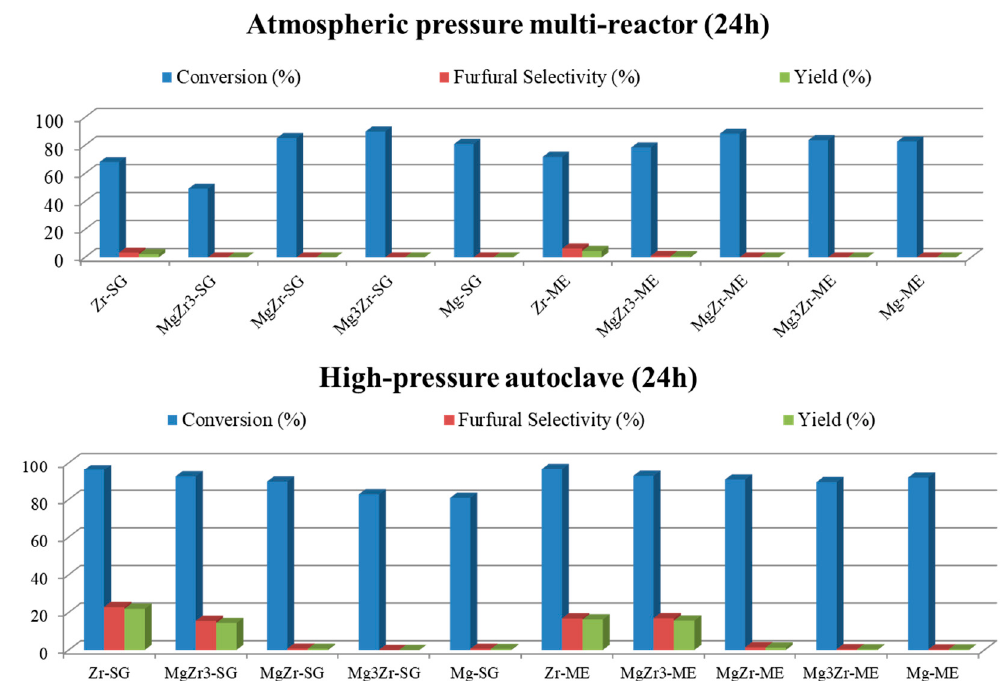
Figure 7. Catalytic activity for both series of catalysts in xylose dehydration in an atmospheric pressure multi-reactor ( upper ) and a high-pressure autoclave ( lower ) in a butan-1-ol/water biphasic media at 150 °C. Xylose conversion and furfural selectivity and yield.